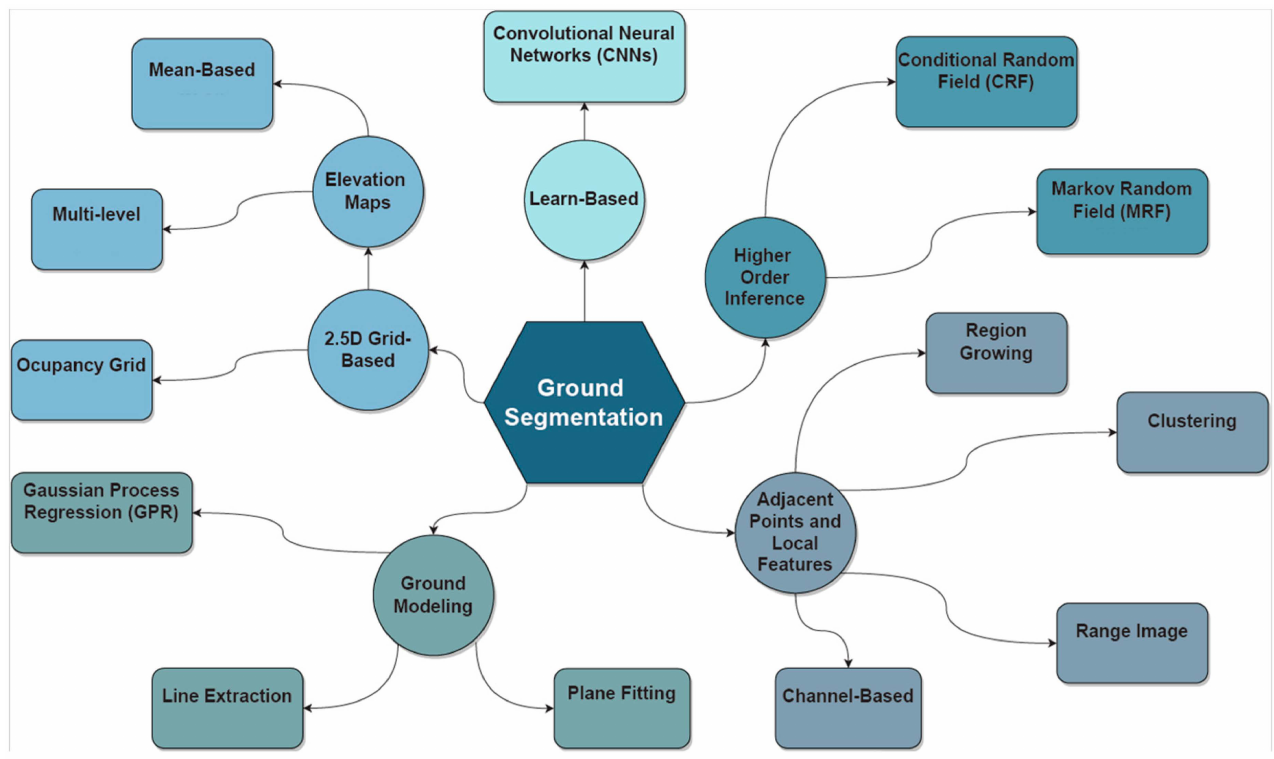
Figure 4. Basic principle of the ground segmentation task.